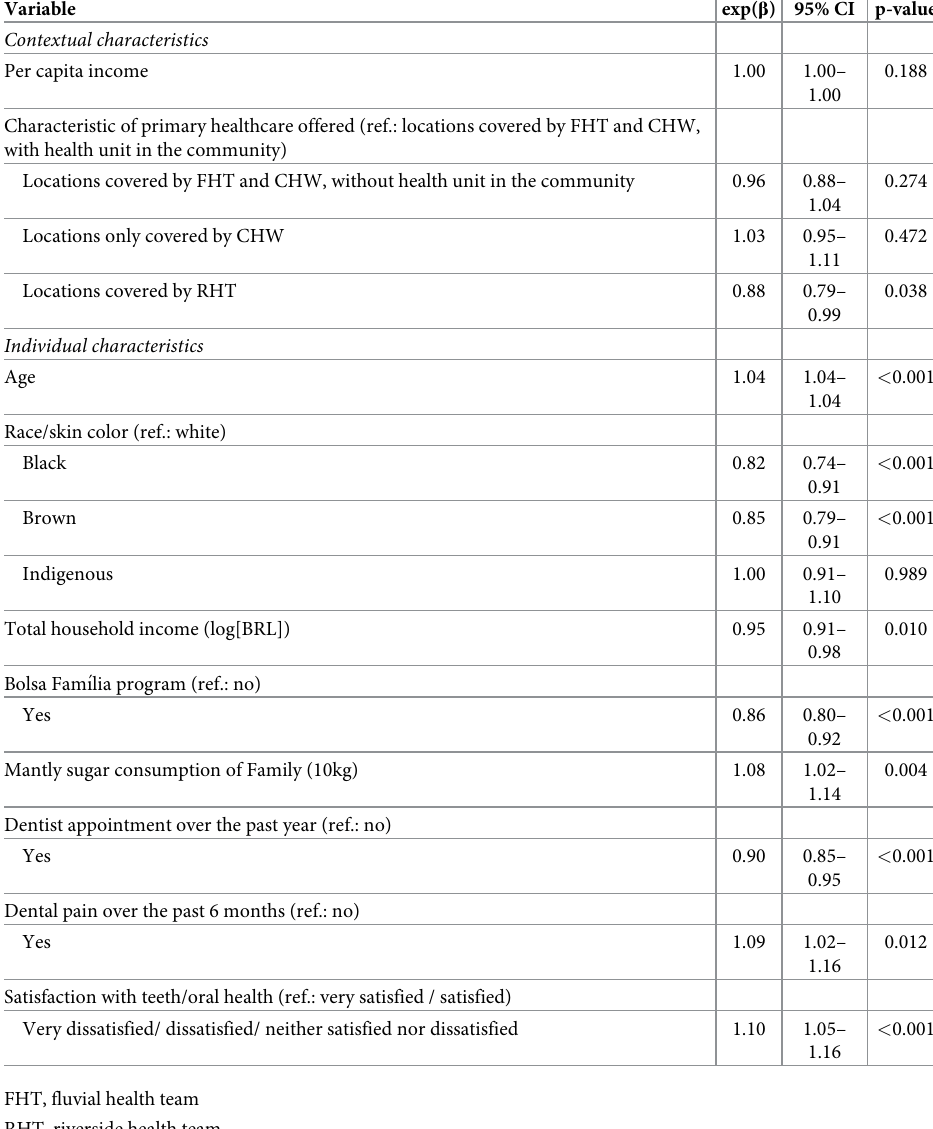
1.00– 0.188 1.00